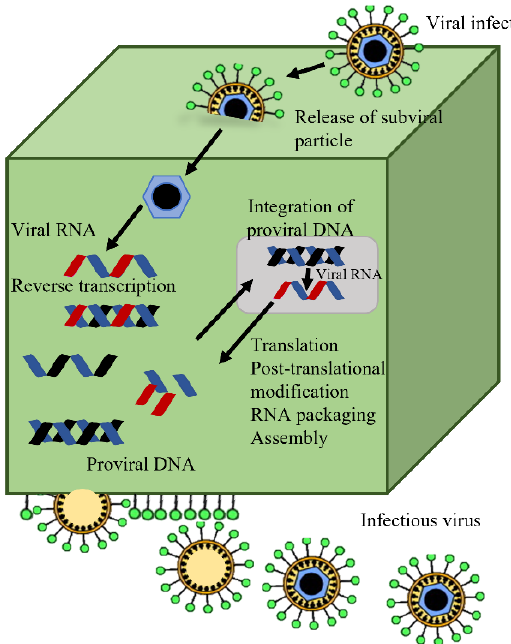
Figure 6. The appeal of retroviral vectors for transgenesis is seen in the usual retrovirus life cycle. Viral RNA is reverse-transcribed into proviral DNA during viral infection, and this proviral DNA is further incorporated into the host genome (modified from Mozdziak and Petitte [29]).